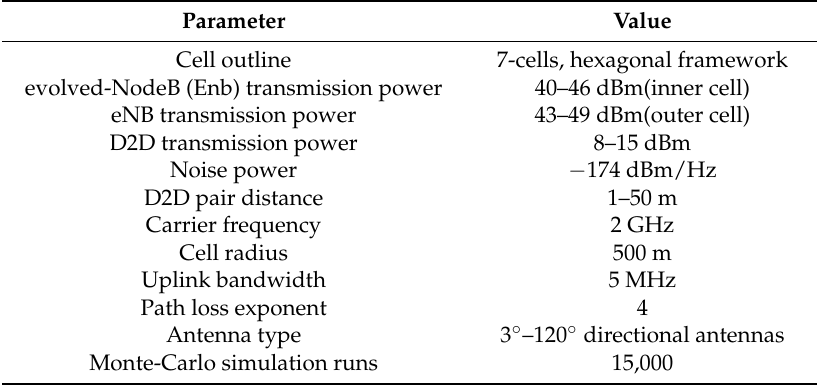
Table 3. Parameters used in